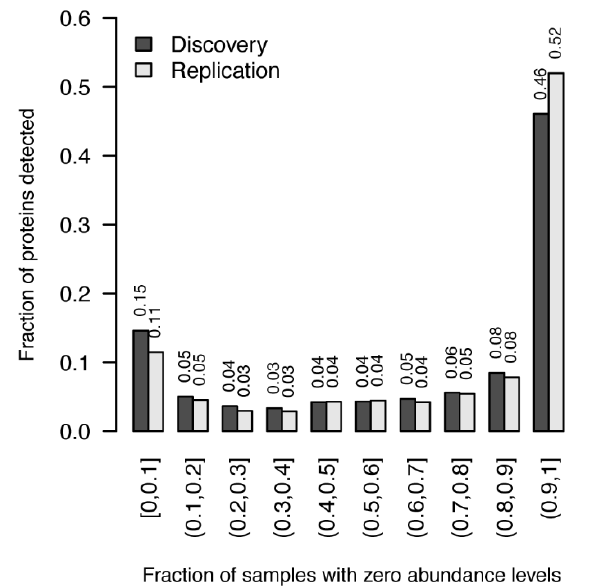
Figure 1. Protein detection rates. The fraction of protein (y-axis) with a specific zero-detection rate across samples (x-axis) for the discovery and age-matched replication cohorts (Case1 and Control in Table 1). For instance, 46 and 52% of the proteins detected in at least one sample were not detected in 90% or more of all analysed samples, while 15 and 11% of the proteins were detected in at least 90% of the samples.